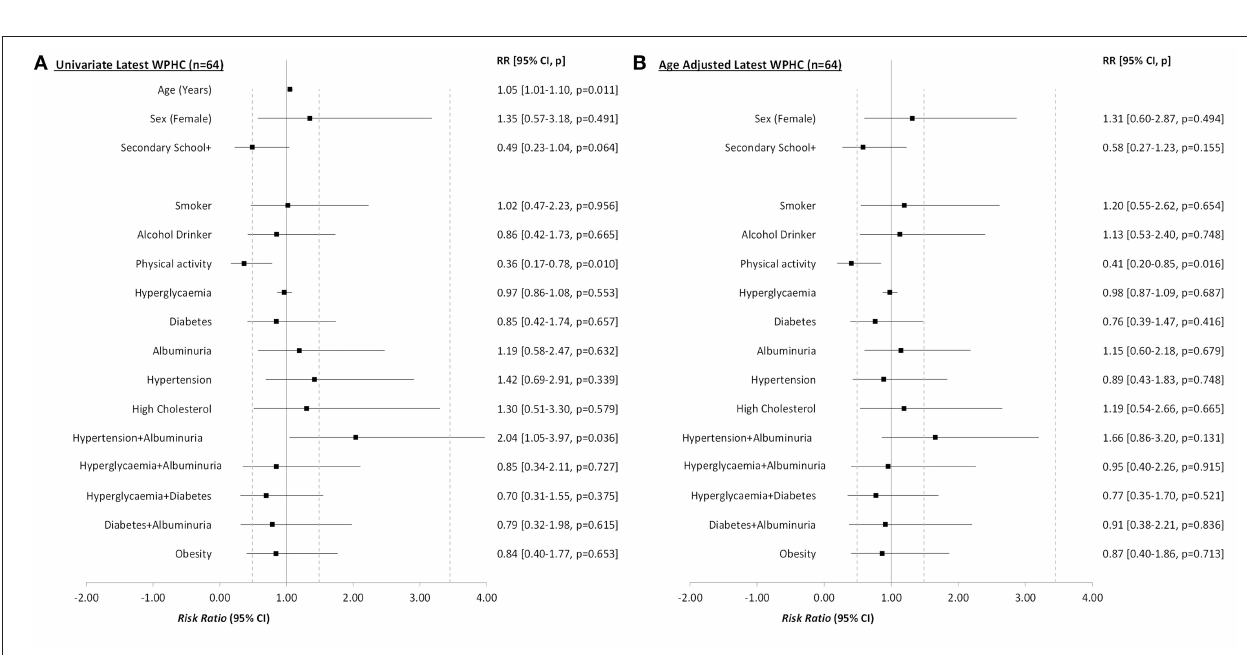
FIGURE 3 | Univariate (A) and age adjusted (B) risk ratios (RR) from generalized linear model analyses of the latest risk and protective factors for Cognitive Impairment Not Dementia (CIND) or dementia, among 64 Aboriginal and Torres Strait Islander residents who participated in the Well Person’s Health Check (WPHC) (1998/2000, 2005/2006), by dementia status at follow up (2015–2018). Secondary School lost significance during modeling, this was due to collinearity with other variables and once these variables were removed, age remained significant. Analyses were repeated with subsets of the